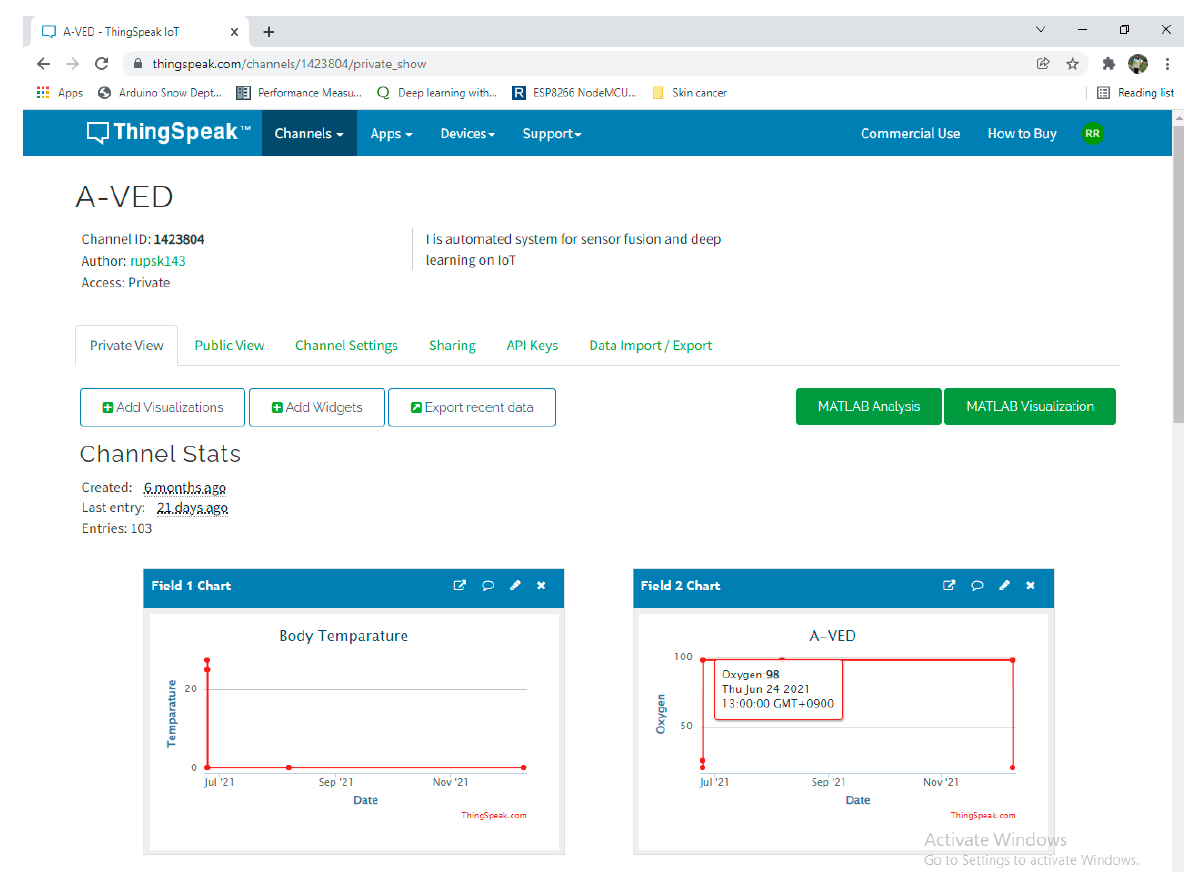
Figure A4. IoT cloud server ThingSpeak channel.